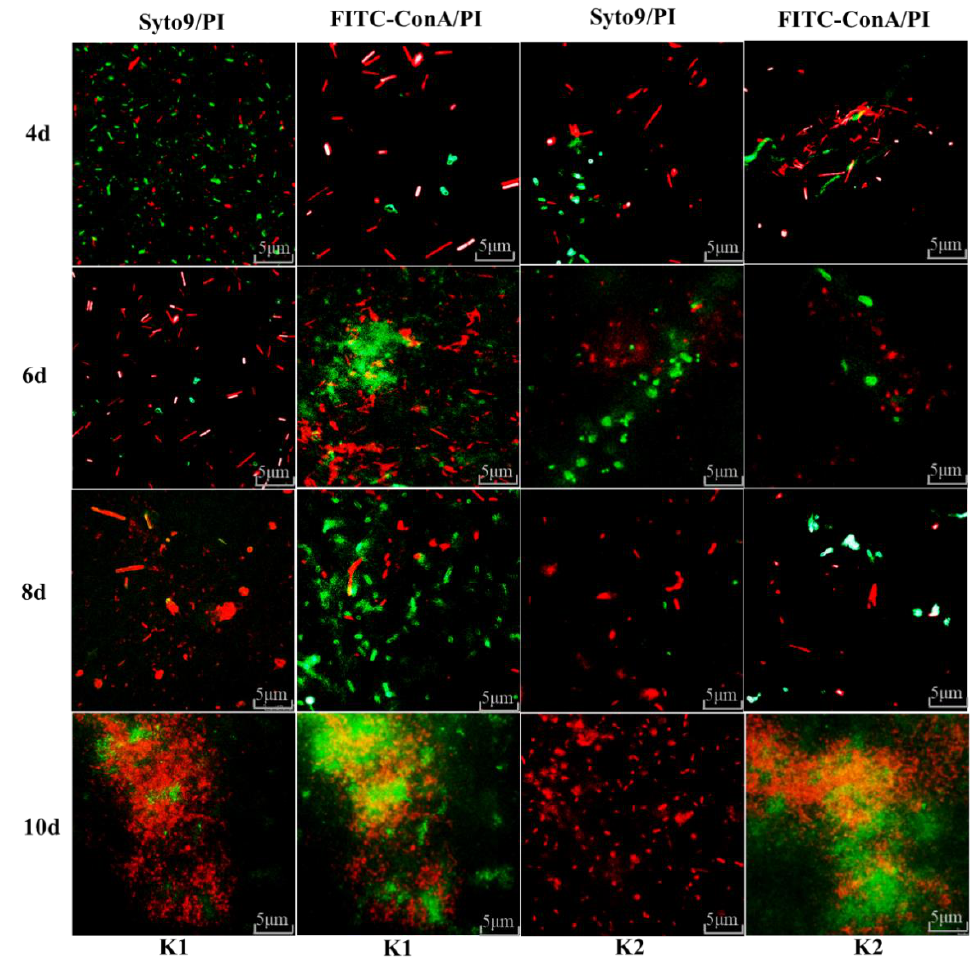
Figure 5. Fluorescence microscope observation on the formation of kefir biofilm. Scale bar = 5 μm. Live cells and dead cells of biofilms were stained with Syto9 (green) and PI (red); the EPS and dead cells of biofilms were stained with FITC-ConA (green) and PI (red).